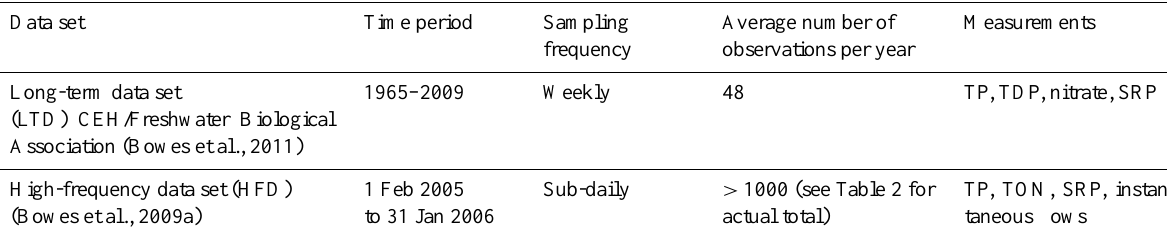
Table 1. Attributes of Frome water quality monitoring data sets.